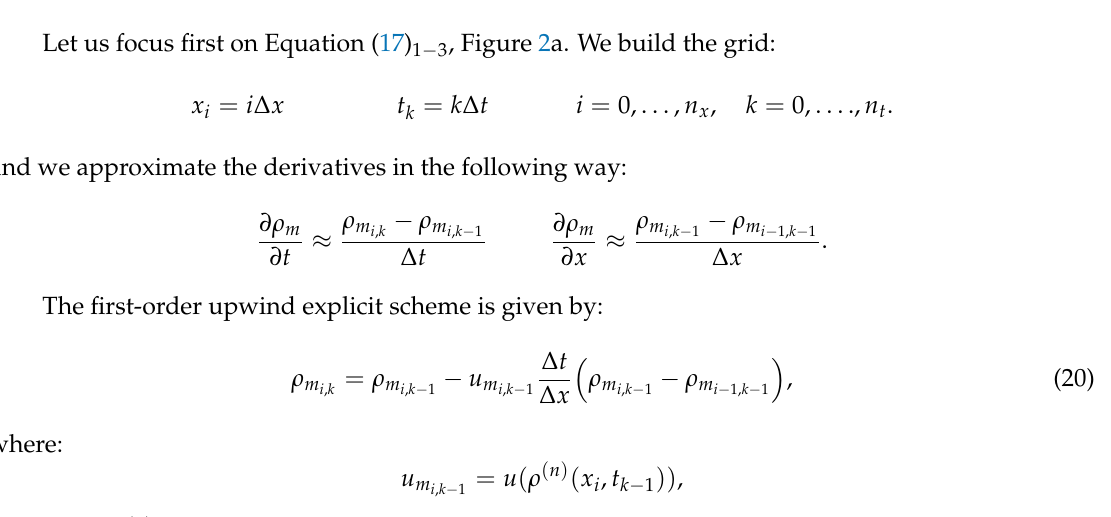
Figure 2. Stencil for the 2D and 3D